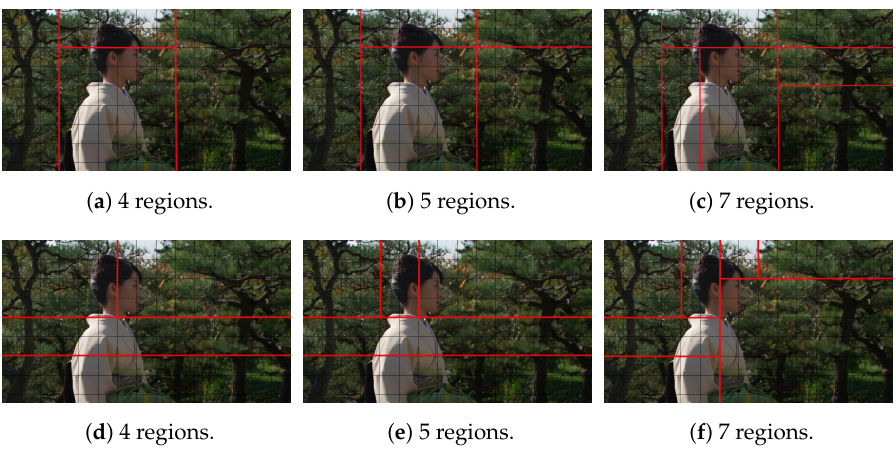
Figure 8. Kimono video sequence: ( a – c ) Serial Region Growing, ( d – f ) Concurrent Region Growing.